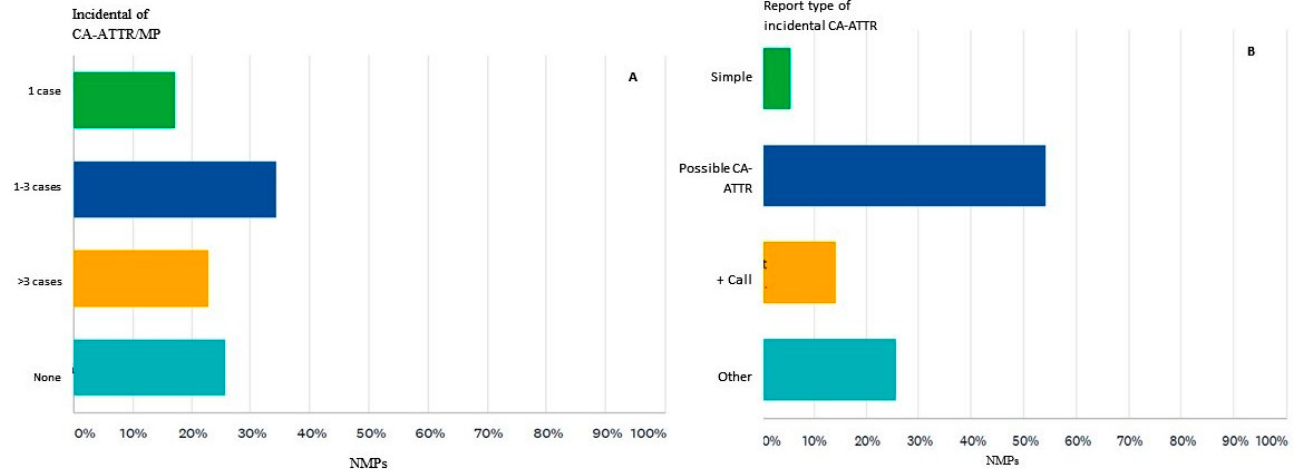
Figure 3. ( A ) The number of cases of diffuse increased myocardial uptake on bisphosphonate